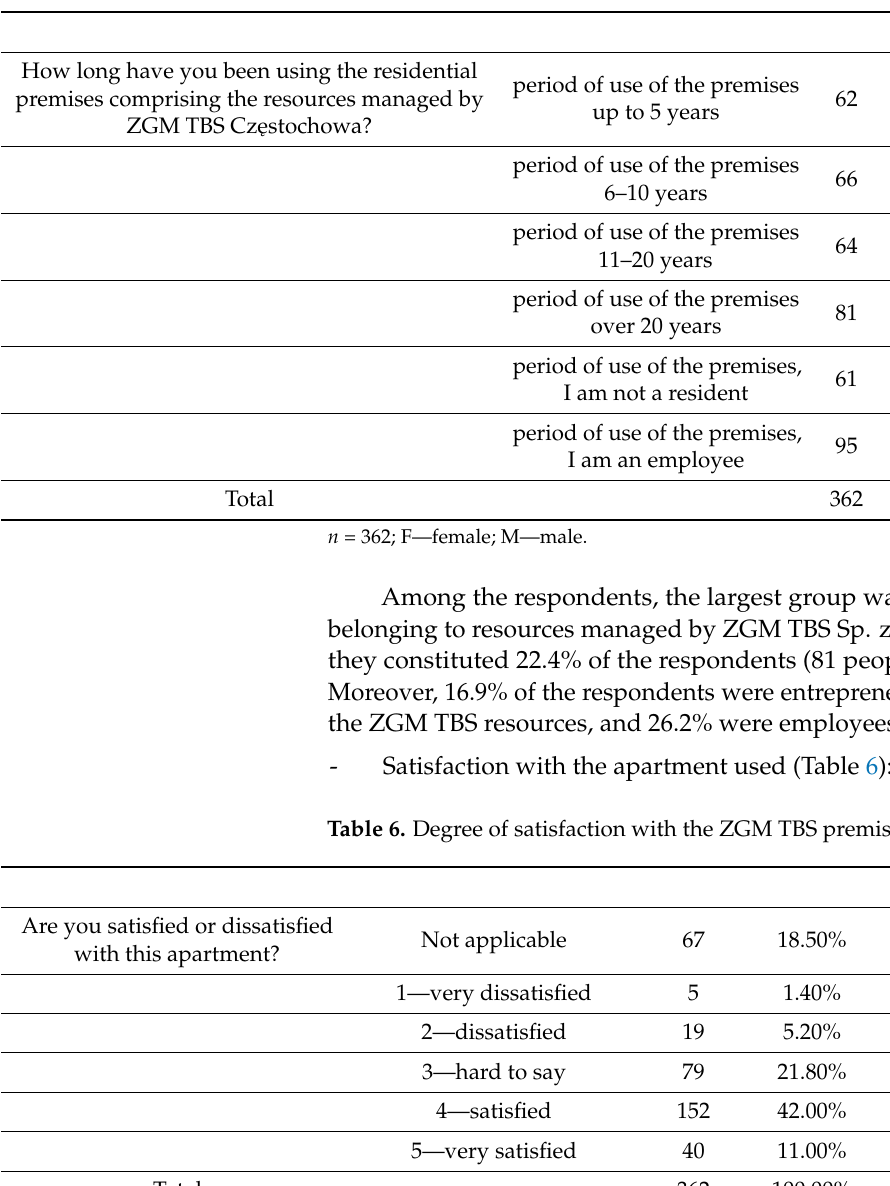
Table 5. Period of using the residential premises belonging to the resources of ZGM TBS.